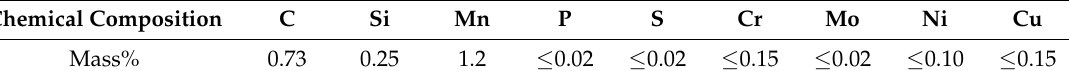
Figure 1. Measured distribution of electromagnetic intensity in the mold under different current intensity.